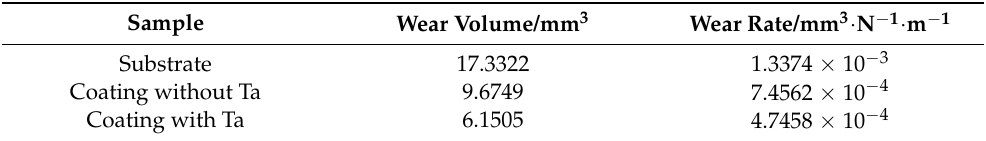
Figure 8. Worn profiles of the substrate and the coatings subject to friction in the neutral environment. Table 5. Wear volumes and wear rates of the substrate and the coatings subject to friction in neutral